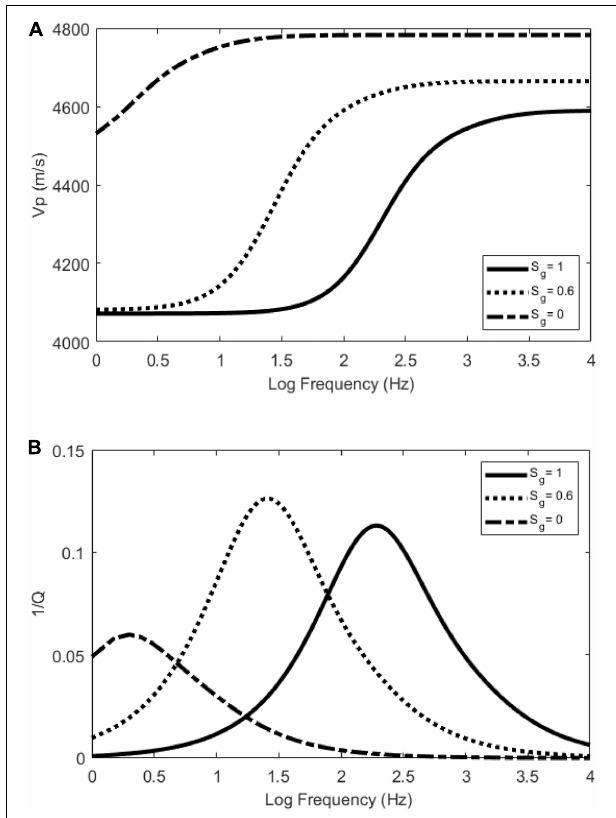
FIGURE 2 | (A) Dispersion of Vp; and (B) attenuation factor 1/ Q for various gas saturations Sg.